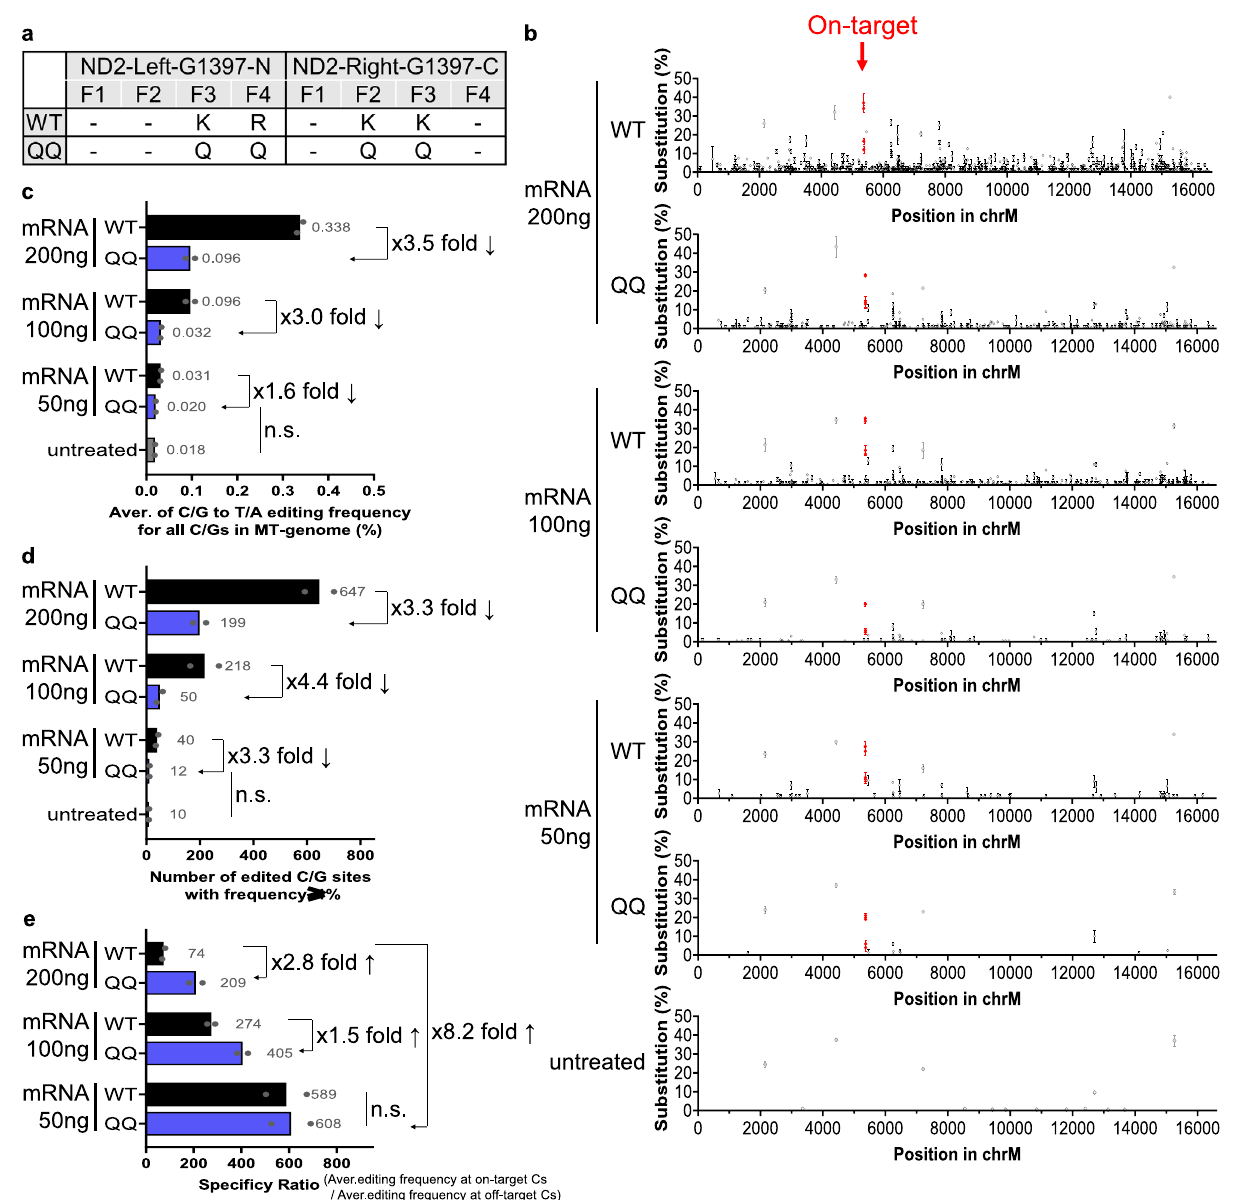
Fig. 5 Improving the mitochondrial genome-wide target speci fi city of mitoZFDs. a QQ mitoZFD variants contain R(-5)Q mutations in each zinc fi nger in the ZFD to remove non-speci fi c DNA contacts. F1 – F4; Finger 1 – 4. (If no R was present at position-5 of the zinc fi nger framework, a nearby K or R was converted to Q.) b Whole-mtDNA sequencing of mitoZFD-treated cells. Editing frequencies at on-target and off-target sites are indicated by red and black dots, respectively. Error bars are shown as standard error of the mean (s.e.m.) for n = 2 biologically independent samples. All C/G-to-T/A base changes present at frequencies >1% are presented. c – e Editing ef fi ciencies and speci fi cities depend on the dose of ZFD-encoding mRNA delivered. Data are shown as means from n = 2 biologically independent samples. c The average C/G-to-T/A editing frequency for all C/Gs in the mitochondrial genome. d The number of edited C/G sites with base editing frequencies >1%. e The speci fi city ratio was calculated by dividing (average editing frequency at